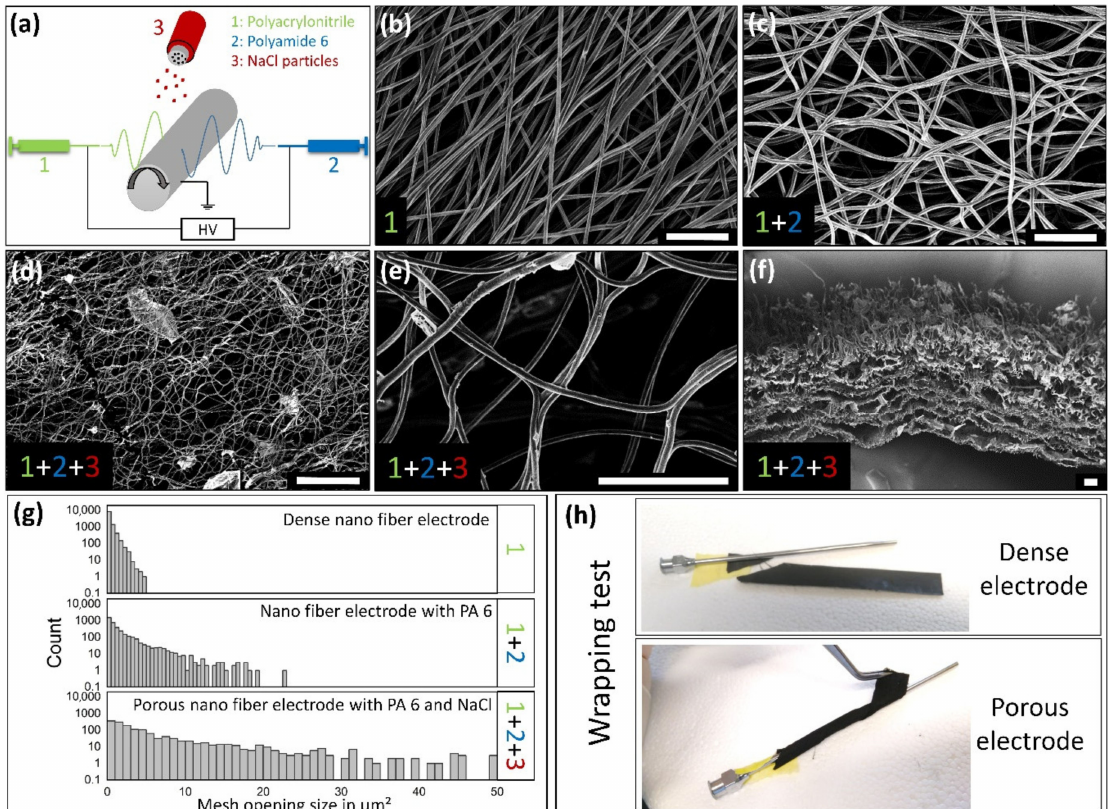
Figure 1. Electrode synthesis and structural properties. ( a ) Schematic E-spinning setup demonstrates the coaxial spinning process with simultaneous generation of two nano fibrous polymers, namely polyacrylonitrile (PAN) and polyamide 6 (PA). NaCl particles were sprinkled on the nanofiber mesh during short interruptions of the spinning process. ( b ) SEM image of a dense electrode from carbonized (PAN) fibers completely without porogens. ( c ) The addition of PA nanofibers in the spinning process results in an increase of the mesh openings. ( d , e ) Further integration of particular porogens (NaCl) lead to an additional increase of the mesh opening sizes. ( f ) Cross section reveals the homogeneous distributed pores formed by the NaCl particles. ( g ) Histogram of the mesh openings shows the quantitative increase caused by the addition of the porogens. ( h ) The loose fiber network as well as the pores greatly improves the nanofiber scaffolds’ flexibility, which was demonstrated by wrapping stipes of the carbon fiber scaffolds around a cannula (d = 2.5 mm). Scale bars correlate to 10 µ m in ( b , c , e ) and to 50 µ m in ( d , f